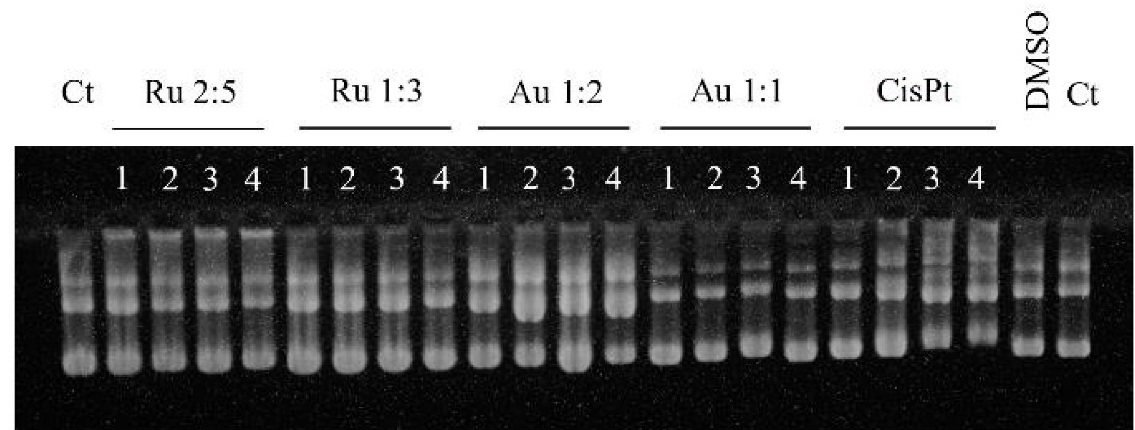
Figure 3. Electrophoretic mobility of pJoJo plasmid DNA in presence of the different DTC derivatives and cisplatin. The plasmid was incubated with the complexes for 24 h at room temperature. For the gold and ruthenium compounds the following concentrations were realized: column 1–4: 15 µ M, 30 µ M, 45 µ M, 60 µ M, respectively. For cisplatin: column 1–4: 1 µ M, 5 µ M, 10 µ M, 15 µ M, respectively.